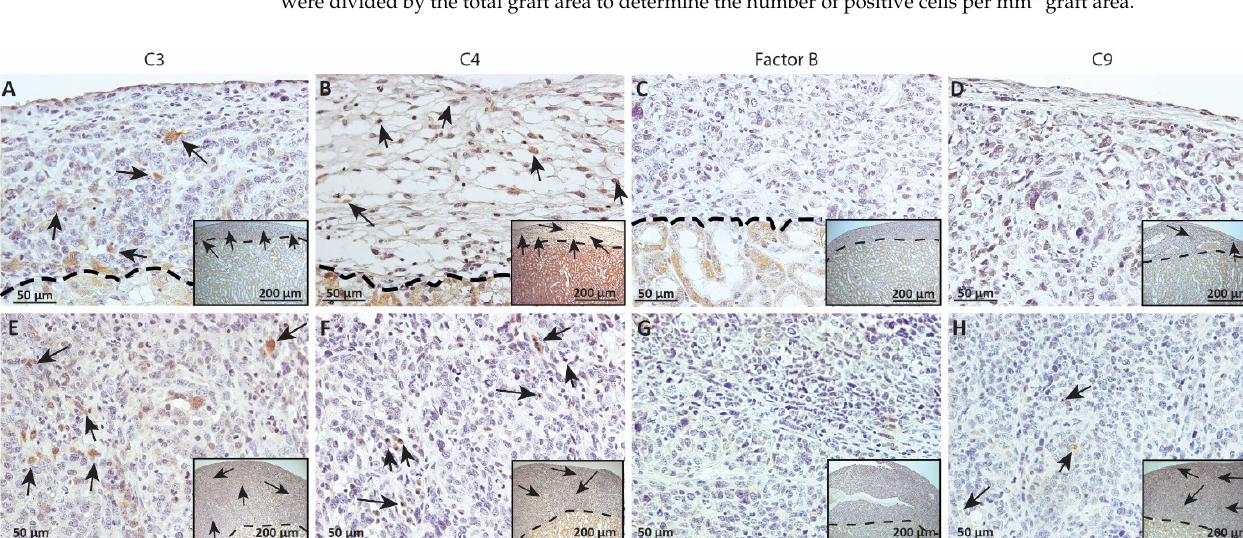
Figure 9. Immunohistochemical analysis of complement fragment deposition on MSC1 chronic timepoint allografts. Graft-bearing MSC1 kidneys were collected at days 20 ( A – D ) and 50 ( E – H ) post-transplantation and tissue sections were immunostained for C3 (brown; A , E ), C4 (brown; B , F ), FB (brown; C , G ), or MAC (brown; D , H ). Insets are lower magnification. A dotted line separates the graft from the kidney. Sections were counterstained with hematoxylin (blue). Arrows indicate ex- amples of positive staining. 2.5. Protein Expression of COMP and C1QBP by MSC1 and MSC1-HI Cells Previously, our group reported that primary mouse SC and MSC1 cells express mRNA for 14 complement inhibitory proteins (CIP) [20]. Of these, MSC1 cells expressed mRNA for C1QBP at significantly elevated levels compared to primary mouse SC (1.205 ± 0.092 ng/mL, p = 0.002) [20]. Here, we used ELISA to quantify protein expression of COMP and C1QBP in MSC1 and MSC1-HI conditioned media. COMP secretion was not detected by MSC1-HI or MSC1. MSC1 cells express C1QBP at 1.593 ± 0.161 ng/mL and MSC1-HI cells express C1QBP at significantly higher levels, 4.560 ± 0.541 ng/mL ( p < 0.01)